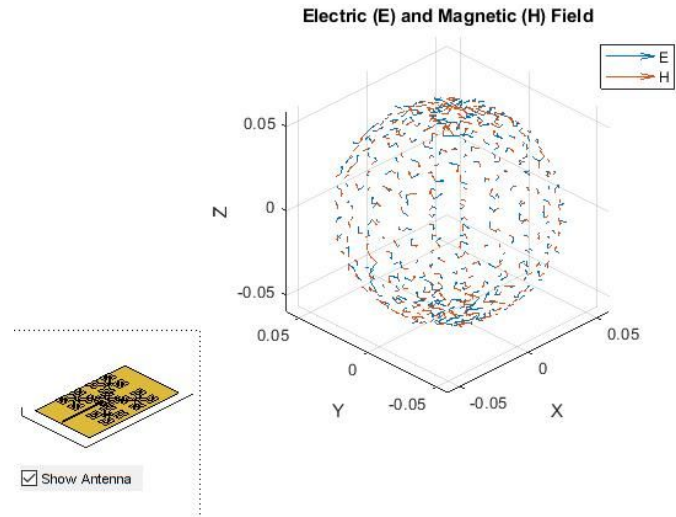
Figure 11. Electric and Magnetic Fields 3D Distribution.